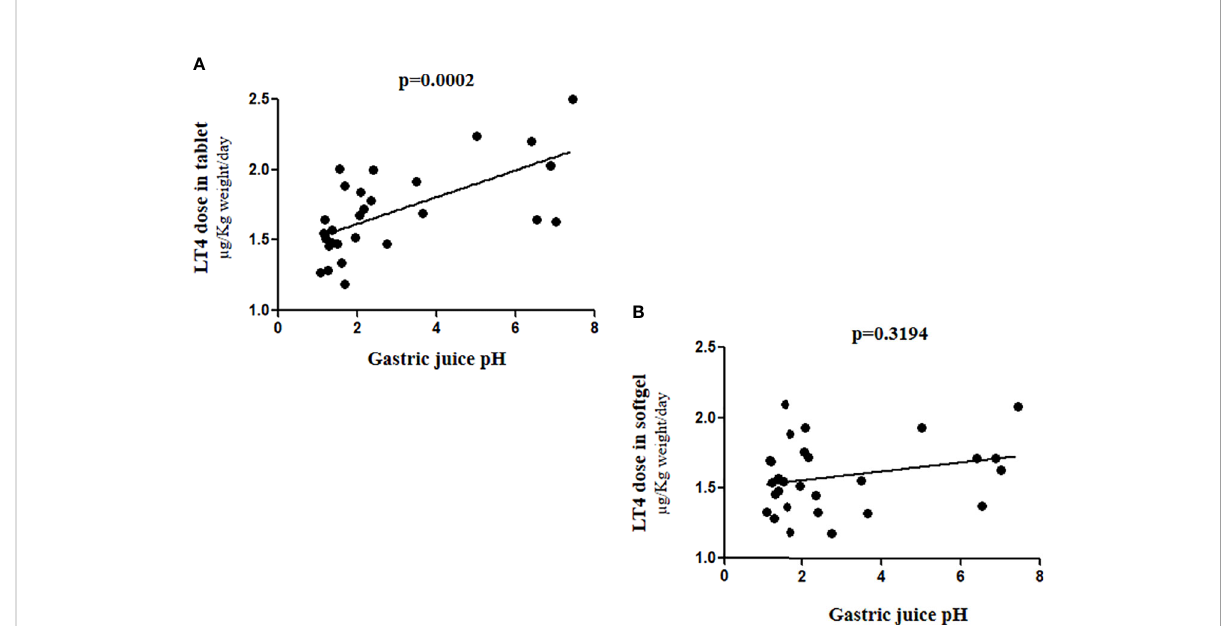
FIGURE 4 Correlation between gastric juice pH values and LT4 requirement in (A) tablet and (B) softgel